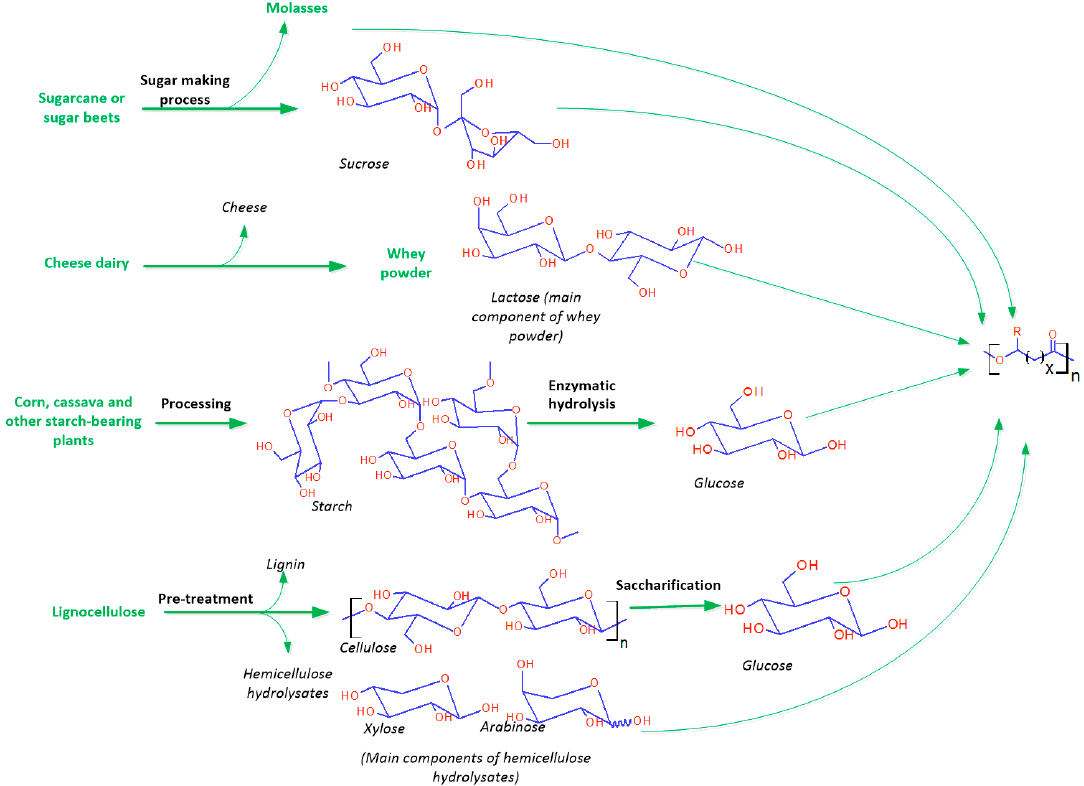
Figure 3. Carbohydrate carbon sources and their transformation processes to simple sugars for fermentative production of PHA. Materials in green indicate the starting raw material from which microbial growth subtrates (in black) are derived.